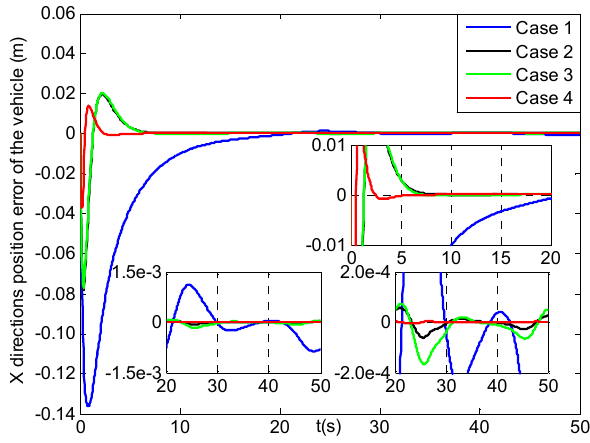
Figure 22. X direction position errors of the vehicle (four cases).